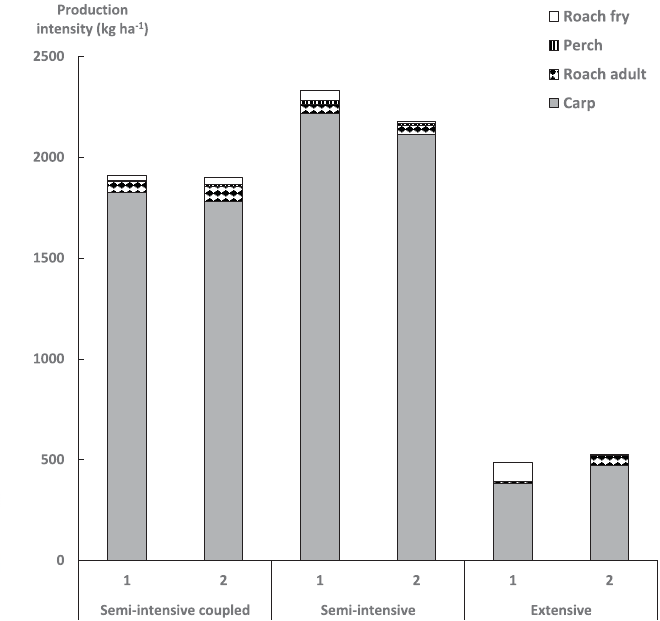
Fig. 2. Correlation matrix between the considered variables in the water. PI is fi sh production intensity, t. is temperature, turbidity is mean water turbidity, X.O2 is oxygen saturation, DO is dissolved oxygen, zooplankton is estimated zooplankton production, BMI is estimated benthic macro-invertebrate production, TP is total phosphorus concentration, TN is total nitrogen concentration, bla is concentration of chlorophyll from blue green algae, bra is concentration of chlorophyll from brown algae, gra is concentration of chlorophyll from green algae, tpp is the total chlorophyll concentration. X.bla, X.bra and X.gra are the proportions of chlorophyll from blue green, brown, and green algae in tpp, respectively. Circles indicate signi fi cantly ( p < 0.05) positive (blue) and negative (red) correlations.